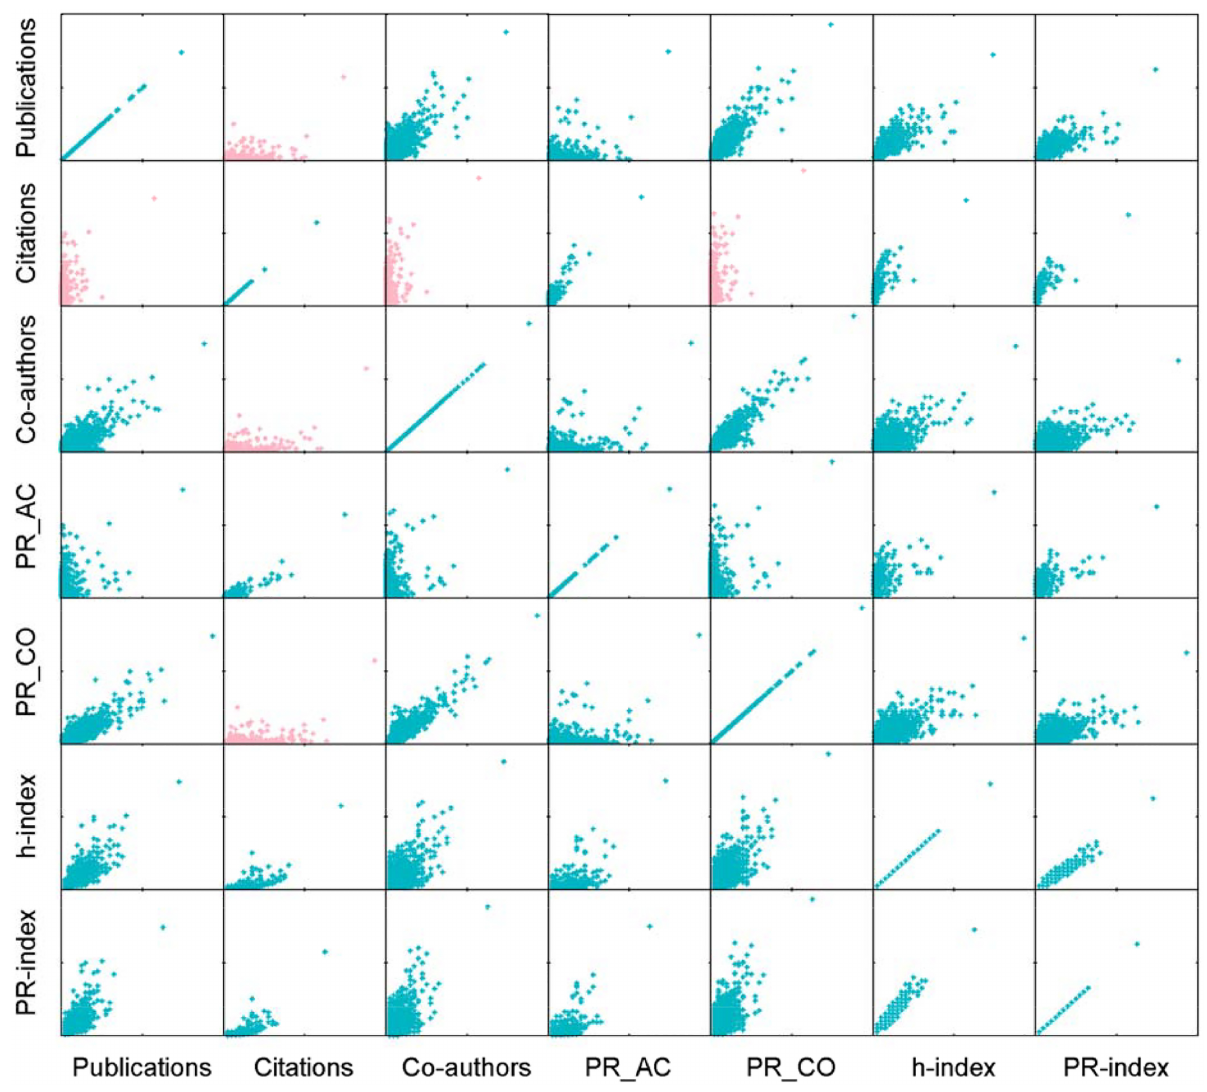
Fig 3. Illustration about the correlation among indicators based on the authors ranking of different indicators. The blue center dots in the principal diagonal show that two indicators highly correlate with each other. The sub figures in pink mean that two indicators are in a lower correlation obviously. This figure illustrates that the evaluation for the same author has the significant differences based on the indicators of Publications and